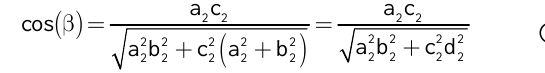
(Figure 4, left) and m 2 =  p 2 Μ 2  , n 2 =  p 2 Ν 2  , s 2 = Μ 2 e 2  , t 2 = Ν 2 e 2  on ε 2 (Figure 4, right).